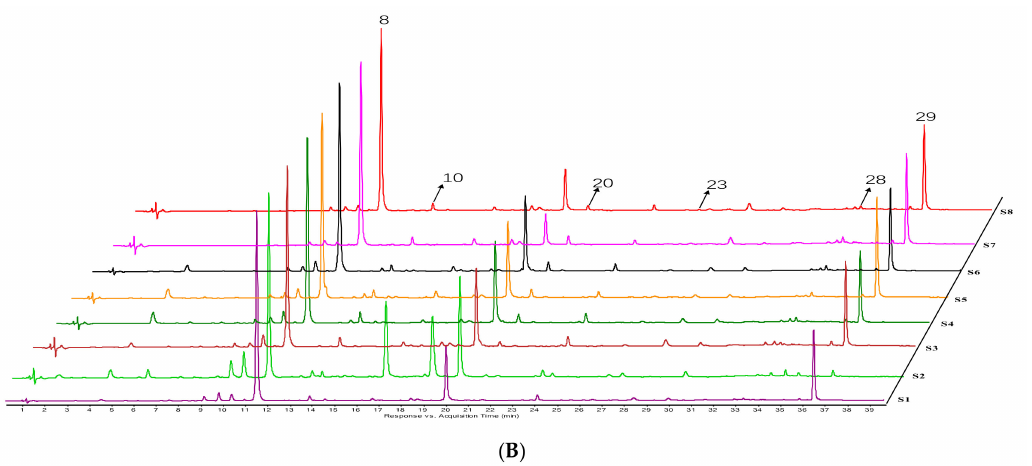
Figure 1. Typical DAD chromatograms of mixed reference compounds ( A ) and the average chromatograms of the sample of post-harvest processing methods ( B